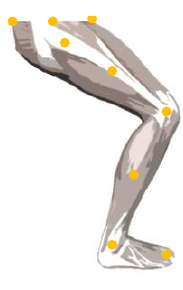
Figure 3. The markers of motion capture system.